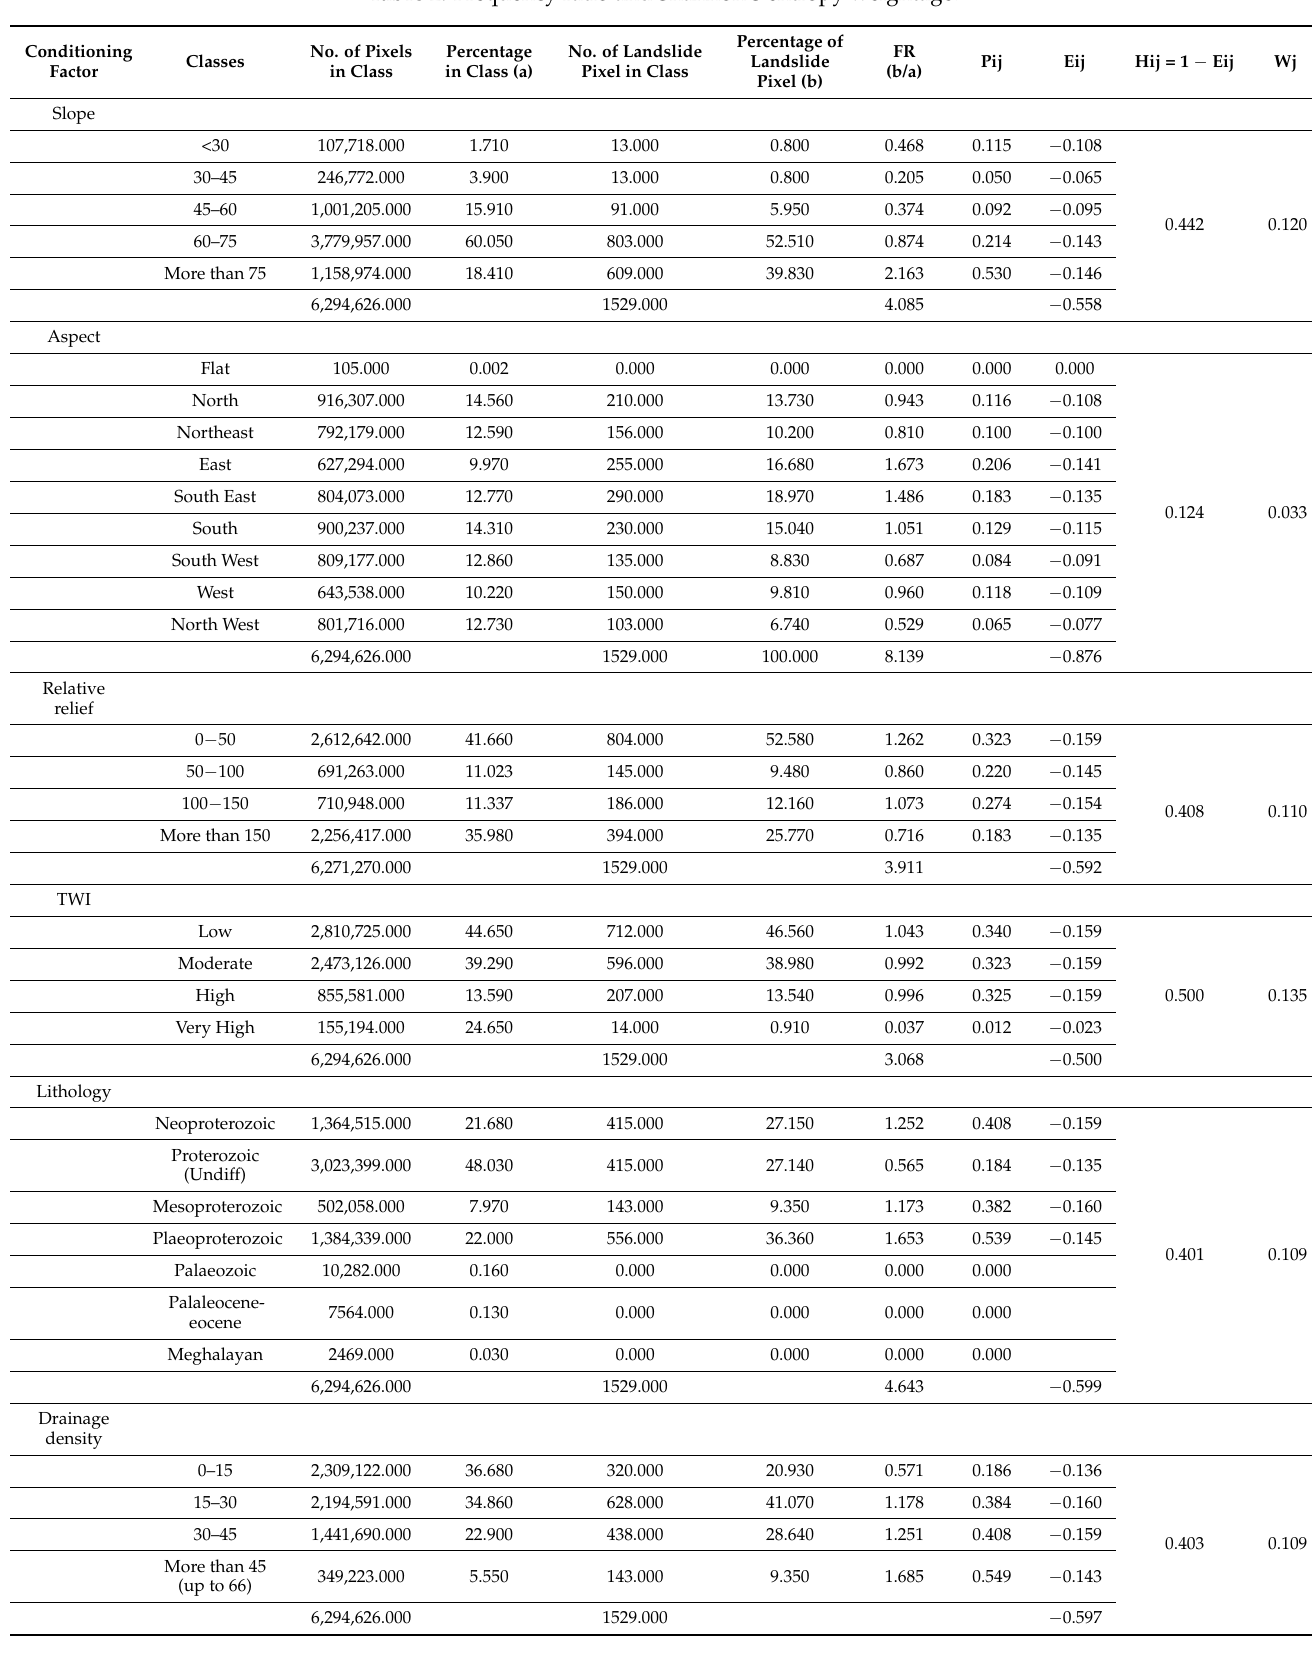
Table 2. Frequency ratio and Shannon’s entropy